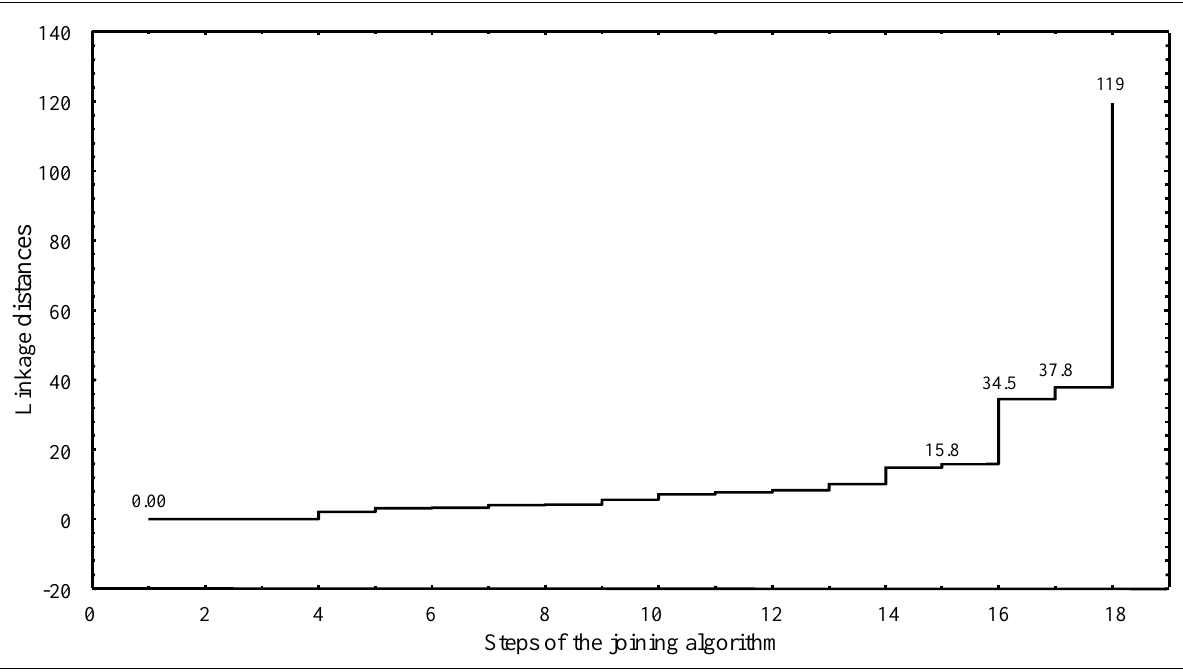
Fig. 4. Increase of the linkage distances (within-cluster dispersion) with the increase in the number of steps of the joining algorithm. Diagram expresses the same data as in Fig.